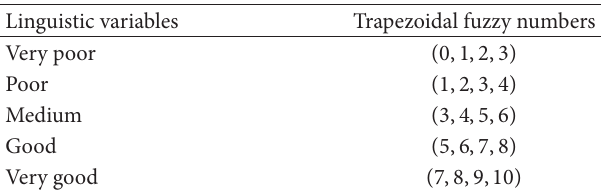
Table 4: List for investigation of the tailings of the XX phosphorus chemical industry in